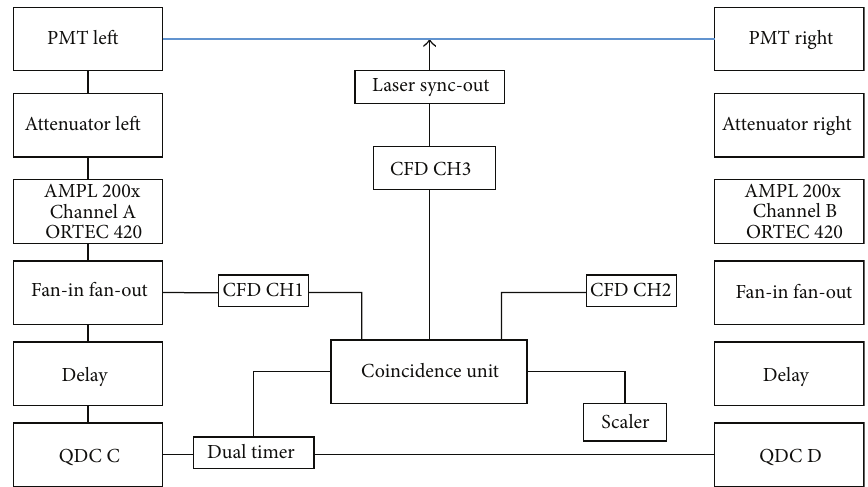
Figure 8: Block diagram of the data acquisition system.